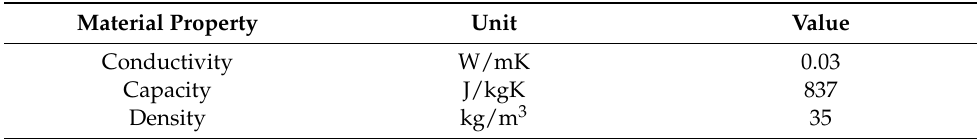
Table 5. Physical characteristics of insulation